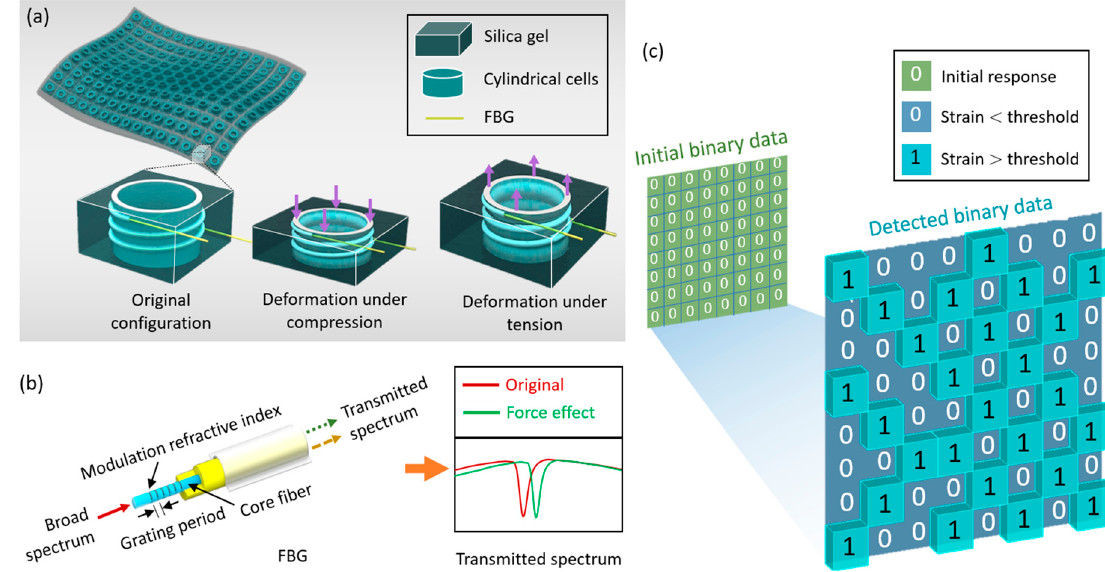
Figure 1. Design principle of the mechanical sensors. ( a ) Illustration of powerless mechanical sensors and configuration changes from original to deformed under external excitations. ( b ) Principle of fiber Bragg grating (FBG) under the influences of external force. ( c ) Binary data (i.e., detected response) converted from the structural instability, which indicate the deformation of the cylindrical cells larger than the predefined thresholds.